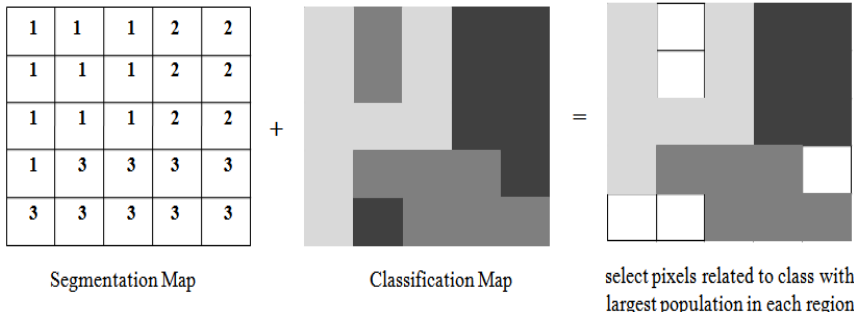
Figure 2. An example of the interference segmentation map in SVM classification map.